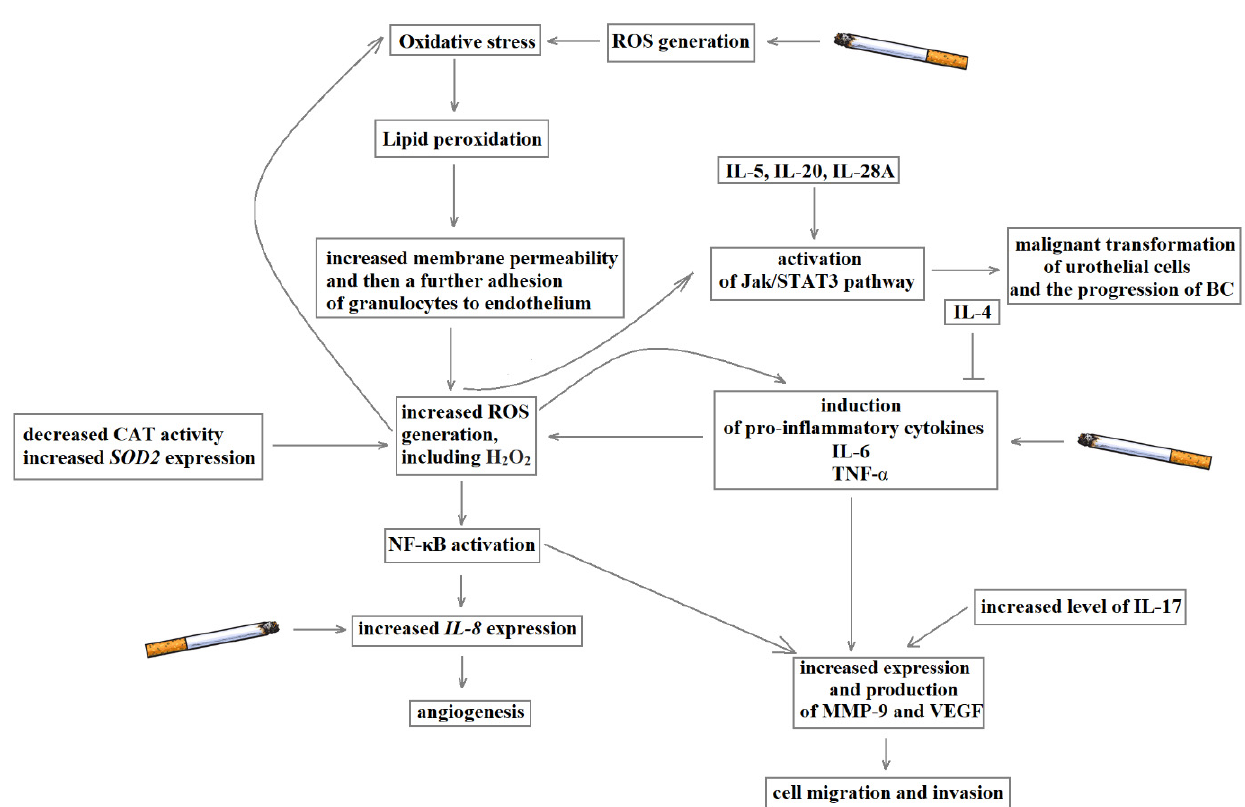
Figure 4. The mutual interaction of oxidative stress, inflammation and angiogenesis in the development of bladder cancer.